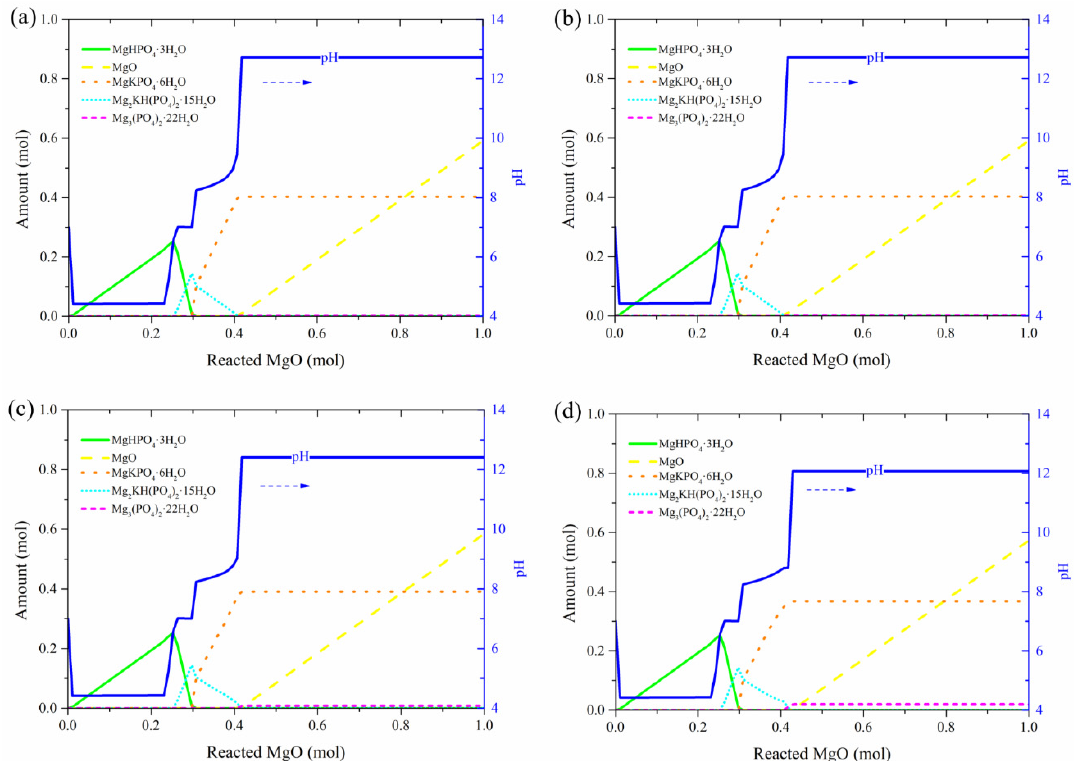
Figure 3. Evolution of amount of hydration products with reacted amount of MgO in ( a ) MP2.7B0K; ( b ) MP2.7B0.25K; ( c ) MP2.7B1K; and ( d ) MP2.7B2.5K.